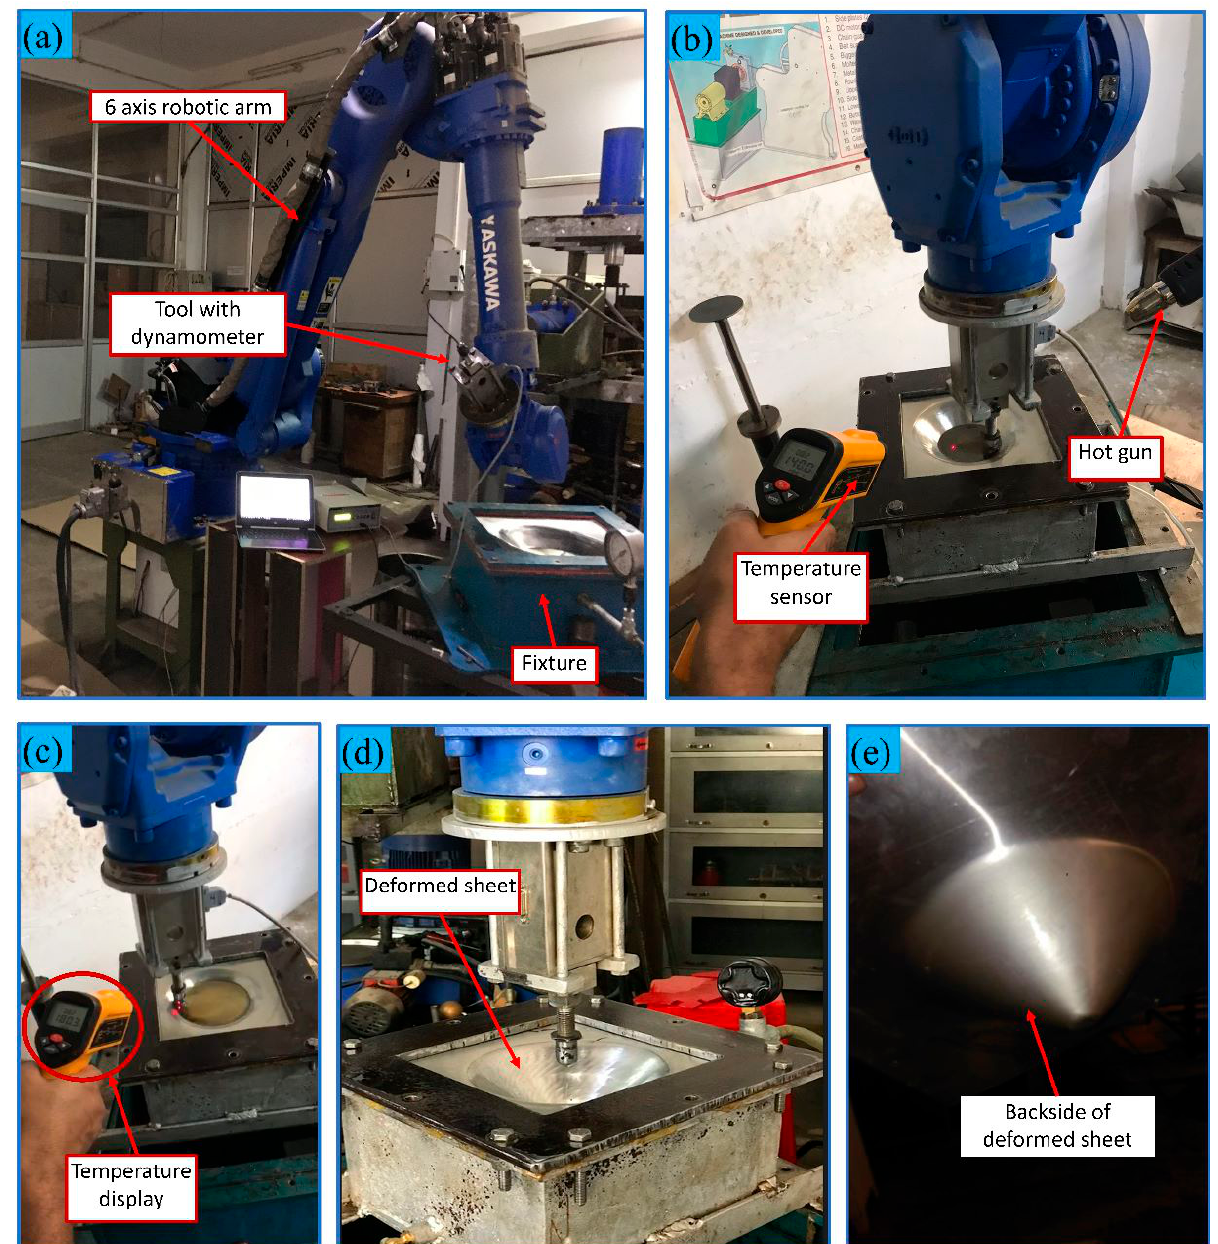
Figure 6. Robot-assisted incremental sheet hydroforming setup: ( a ) labeled diagram of existing setup, ( b ) setup with temperature measurement and hot gun, ( c ) temperature display, ( d ) experimentally formed cone showing inner surface along with tool, and ( e ) experimentally formed cone showing outer surface of the cone.